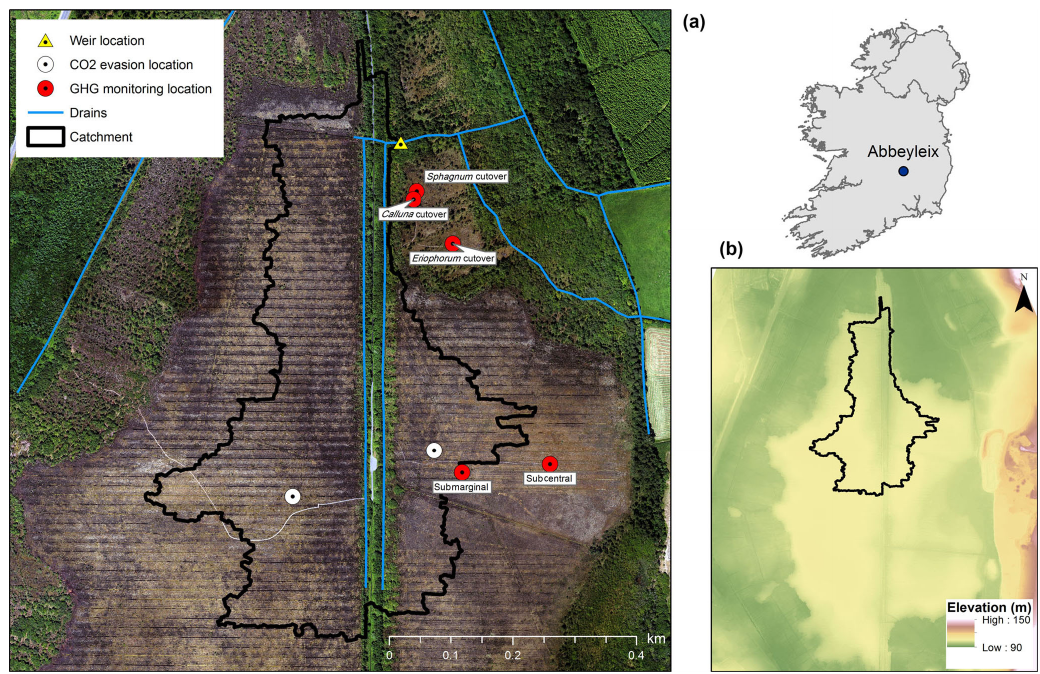
Figure 1. Location of the study site in Ireland; elevation map of Abbeyleix Bog (bottom right) showing the uncut raised bog surrounded by lower cutover bog and the higher esker complex to the east; an aerial photograph of the study site showing the weir catchment area, major drains, and sampling locations. In the aerial photograph the blocked surface drainage network on the raised bog can be seen as a set of horizontal lines and the historic railroad track can be seen as a vertical line through the middle of the photograph. White circles represent the open-water CO 2 evasion locations on blocked drains, referred to as west high bog (WHB) and east high bog (EHB). Table 1. Summary of the plant ecology for each ecotype in this study. Data are reported as the mean (range) of the five or six collars within each ecotype. Percentage of Percentage of Percentage of Percentage of total Ecotype Sphagnum spp. cover Eriophorum spp. cover Calluna vulgaris cover plant cover Sphagnum cutover 94 (78 to 100) 8 (3 to 23) 16 (5 to 30) 119 (103 to 134) Calluna